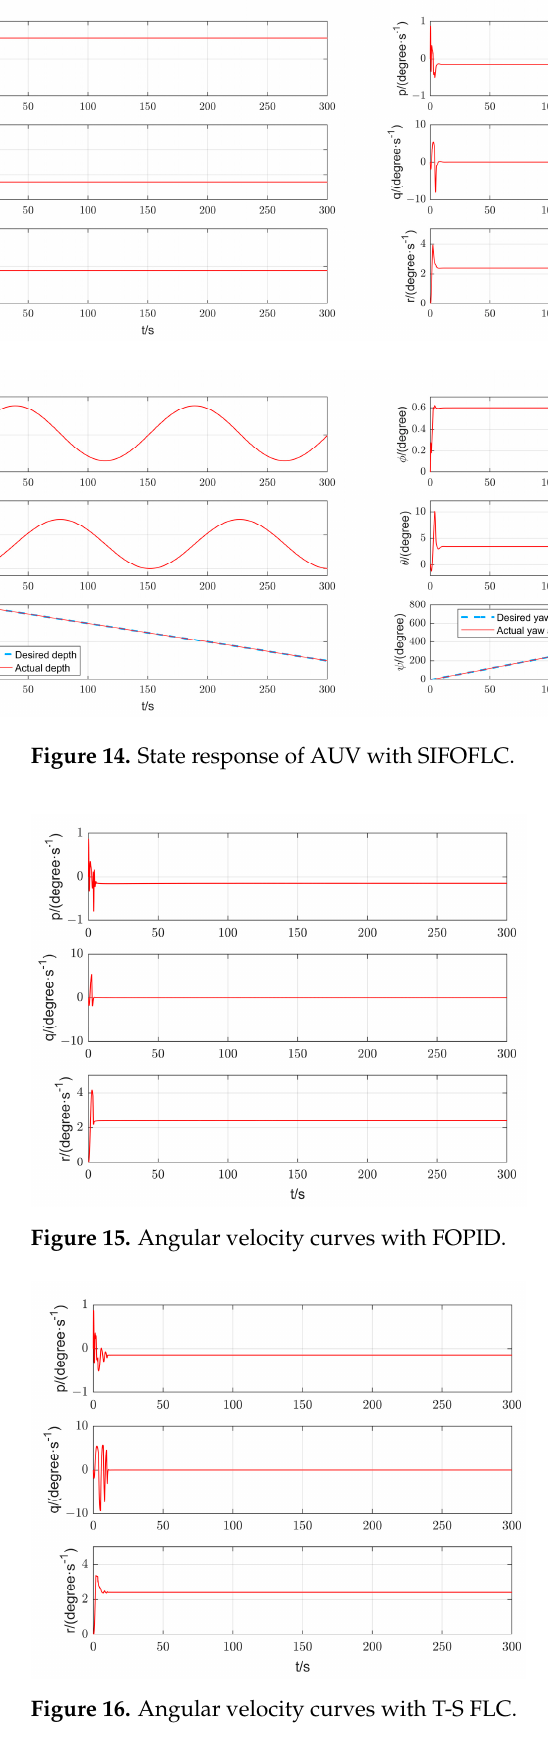
Figure 16. Angular velocity curves with T-S FLC. Table 4. Quantitative analysis of system performance.